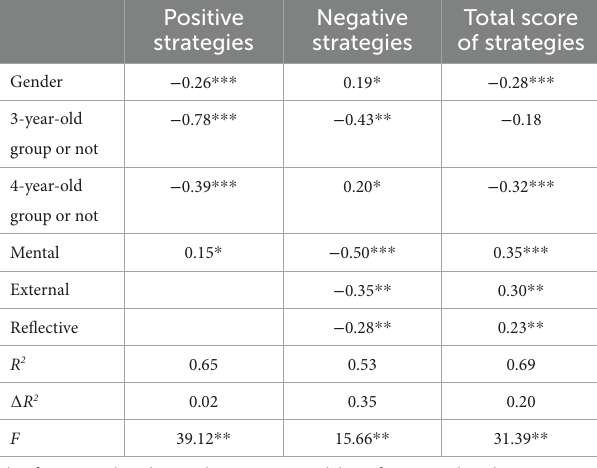
TABLE 7 Regression analysis results of emotional comprehension on children’s peer conflict resolution